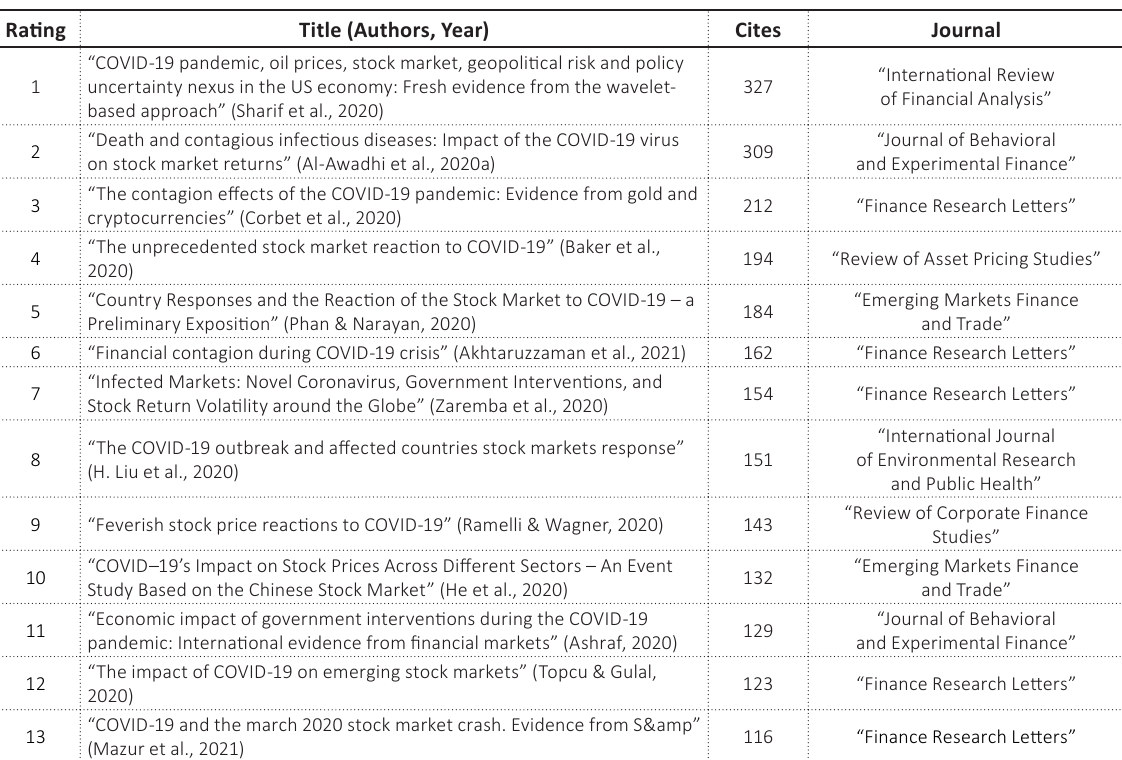
Table 2. Academic articles with the most citations (> 100